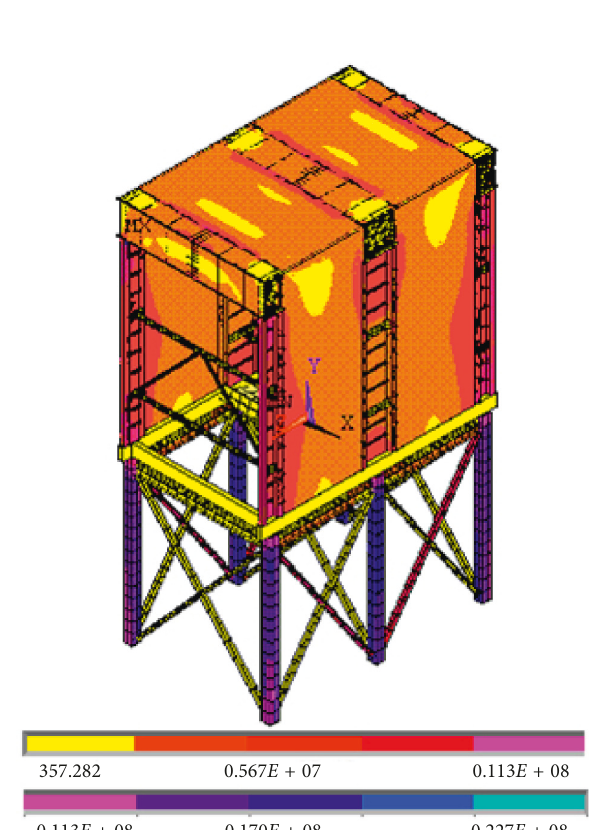
Figure 20: The von Mises stress nephogram of the main structure of the electrostatic precipitator